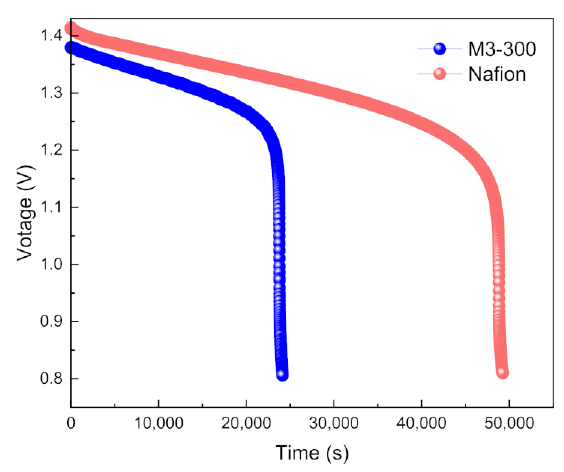
Figure 9. The self-discharge performance of a VFB with M3-300 and Nafion 212 membranes. The polarization curve and power density of the VFB assembled by M3-300 membrane were measured at room temperature and are shown in Figure 6. At the galvanostatic charging mode, the VFB was charged to 20%, 50%, and 90% SOC. Next, the VFB was discharged at the different current densities, and the voltage was recorded, then the power density was calculated. As shown in Figure 10a, the voltage showed a linear decline with the increase in the discharge current density. At 20% or 50% SOC, a VFB with the M3-300 membrane reached the peak power density of 235 mW cm − 2 at the current density of 350 mA cm − 2 . While a VFB with the M3-300 membrane at 90% SOC was capable of delivering a limiting current density of 900 mA cm − 2 , and a high peak power density of 650 mW cm − 2 , which was very competitive among the various flow batteries.